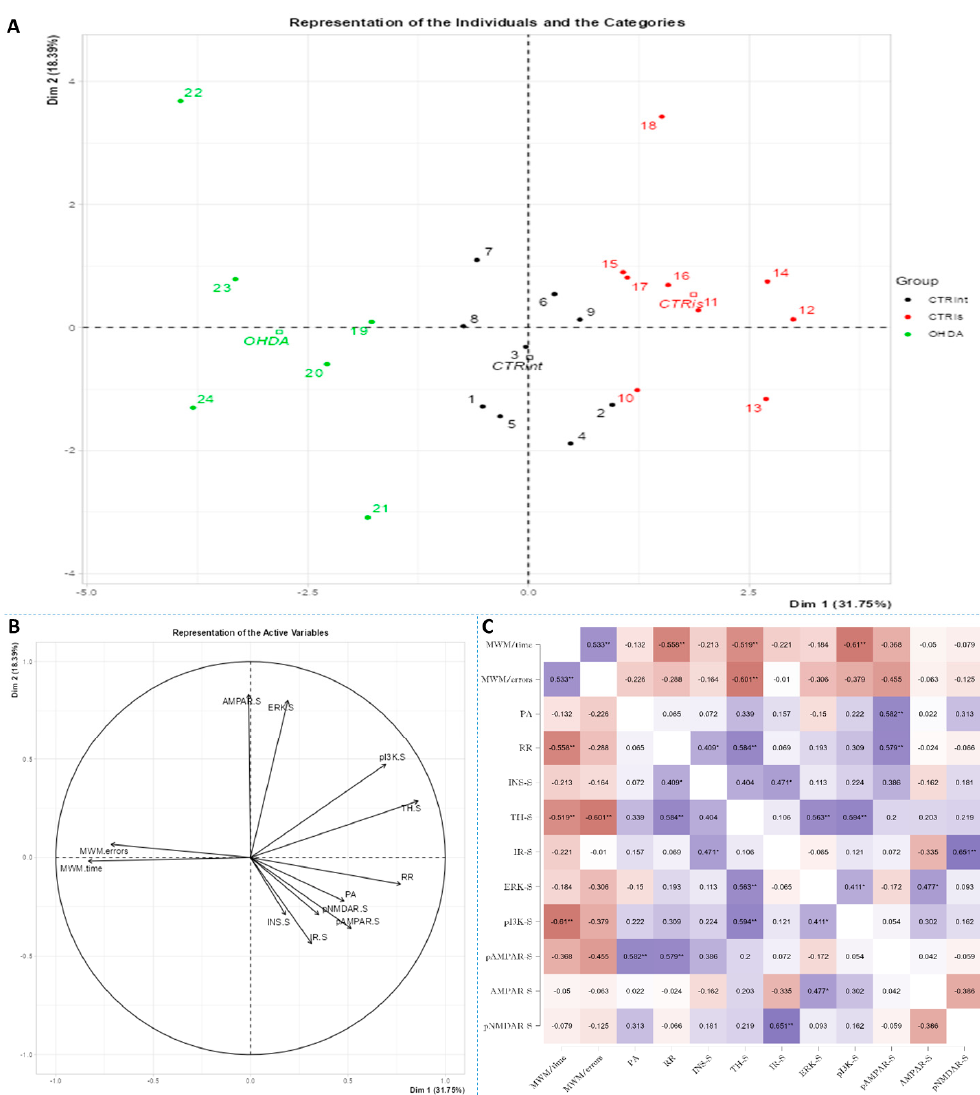
Figure 7. Principal component analysis and Spearman’s rank correlation of observed parameters in the striatum 3 months after intrastriatal administration of 6-OHDA. Striatal (S) principal com- ponent analysis is represented as a biplot ( A ) with coordinates of individual animals in respect to the 1st and 2nd dimensions (principal components) and a biplot graph of the variables’ contribu- tions to the 1st and the 2nd principal component ( B ). Groups are represented in different colors: intact control (CTRint, black), sham-treated control (CTRis, red), animals treated intrastriatally with 6-hydroxydopamine (OHDA, green) ( A ). Spearman’s rank correlation of S parameters is represented as Spearman’s rho heatmap ( C ) with statistically significant correlations indicated with * p < 0.05, ** p < 0.001. Dim 1-1st dimension; Dim 2—2nd dimension; MWM-Morris Water Maze; PA-Passive Avoidance; RR-Rotarod; INS-insulin; TH-tyrosine hydroxylase; IR-insulin receptor; ERK-extracellular signal-regulated kinase; pI3K-phosphoinositide 3-kinases; AMPAR- α -amino-3-hydroxy-5-methyl-4- isoxazolepropionic acid receptor; NMDAR-N-methyl-D-aspartate